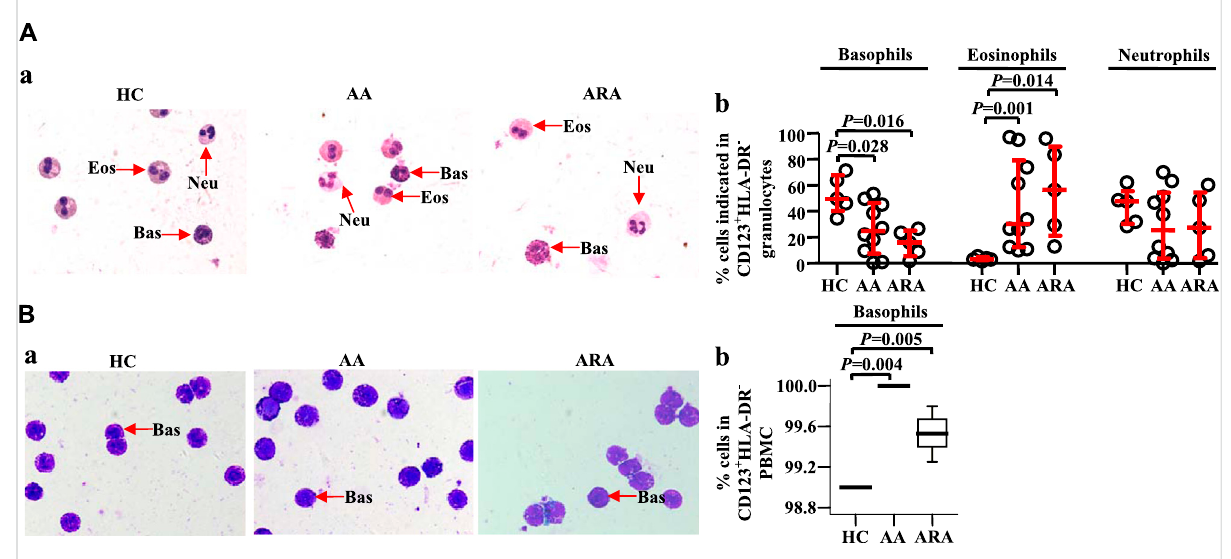
FIGURE 3 Identi fi cation of isolated CD123+HLA-DR − granulocytes and PBMC from human peripheral blood. CD123+HLA-DR − cells in granulocytes (A) and PBMC (B) were sorted by fl ow cytometer, and cytocentrifuge slides were prepared. Following staining with Wright Giemsa stain, differential cell counts under a microscope were performed. Basophils have pale blue cytoplasm containing purple-black secondary granules, and the nucleus is segmented. Eosinophils display pink cytoplasm containing large and medium-sized, spherical, dense granules, and segmented nuclei. The cytoplasm of neutrophils is abundant, pale pink containing many small violet-pink neutrophilic or secondary granules distributed evenly throughout thecellwithalobulatednucleus. (A)and(B)representativegraphs.(C)and(D)percentagesofcellsindicated.Dataweredisplayedasascatterplotfor granulocytes and a boxplot for PBMC, which indicates the median, interquartile range, and the largest and smallest values. Each data represented a group of 5 – 10 separate experiments. Magni fi cation was × 100. The paired Mann – Whitney U test was employed for the analysis of signi fi cant differences between groups. For all analyses, p < 0.05 was taken as signi fi cant by comparison to those obtained with the corresponding HC